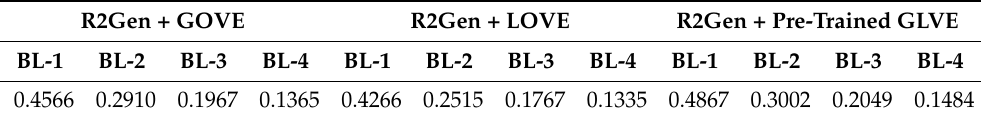
Table 3. The baseline model with the GLVE outperforms both the model with the GOVE and the model with the LOVE in all BLEU scores. R2Gen + GOVE R2Gen + LOVE R2Gen + Pre-Trained